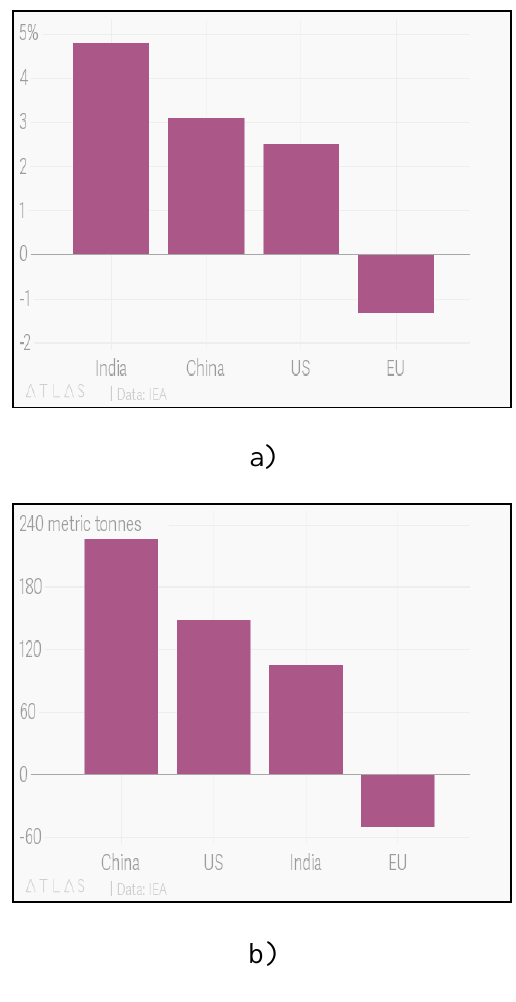
Figure 3. CO emissions growth rate in India: 2 a) growth rate of CO emissions in 2018, 2 b) absolute CO emissions growth in 2018 [13] 2